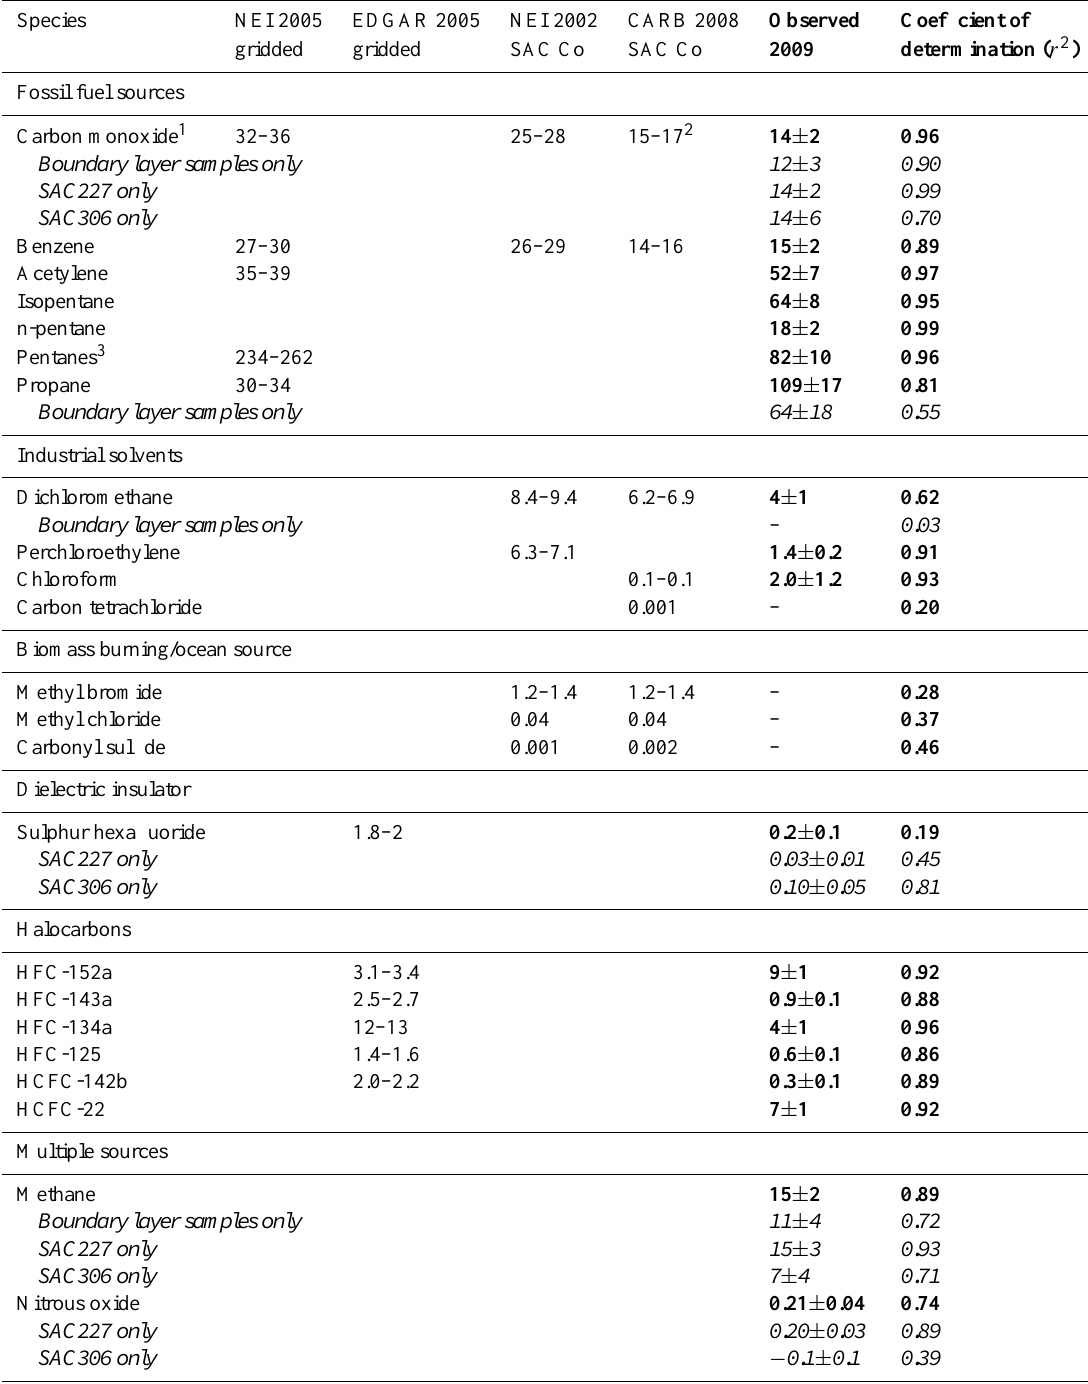
Table 2. Inventory-based and observed R tracer / CO . Emission ratios for CO and CH 4 are reported in ppb/ppm, all others are reported 2 ff in ppt/ppm. Inventory estimates are calculated using the CEPAM CO 2 ff inventory (low value) and Vulcan CO 2 ff inventory (high value). Observed values are calculated from the slope of the relationship between each tracer and CO 2 ff, along with one-sigma uncertainties and coefficient of determination of those slopes. For species where the slope differed significantly when the two flights were considered individ- ually, or when the free troposphere samples were excluded from the fit, the slope is also given for those